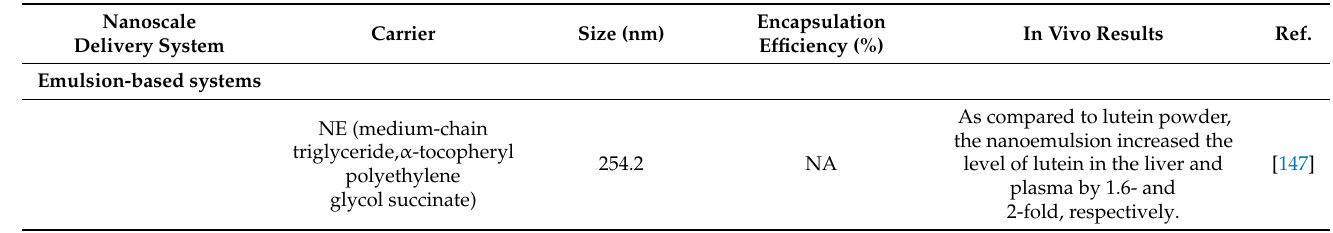
Table 1. Effect of nanoscale delivery systems on the bioavailability of lutein in rodent models. Nanoscale Delivery System Emulsion-based